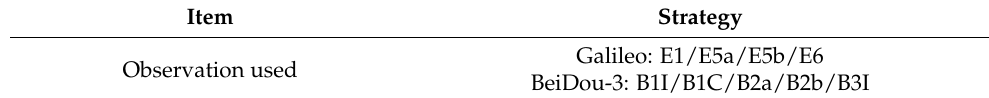
Table 3. Models and parameter estimation strategies in the data